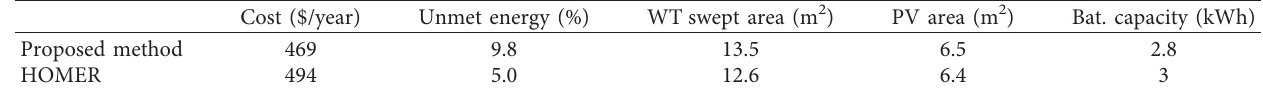
Table 3: Result comparison by the proposed method and HOMER